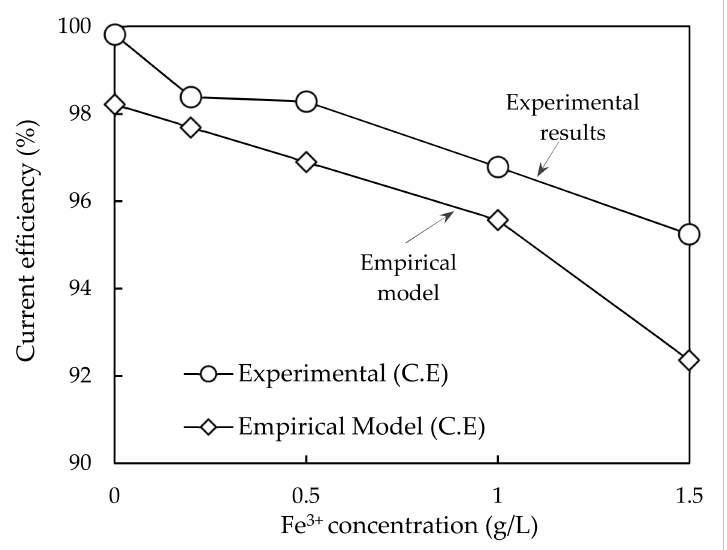
Figure 10. Effect of Fe 3+ on current efficiency (C.E) of copper deposition. (Conditions: current density 250 A/m 2 , temperature 40 ◦ C, electrolysis time 4 h, Cu 2+ concentration 45